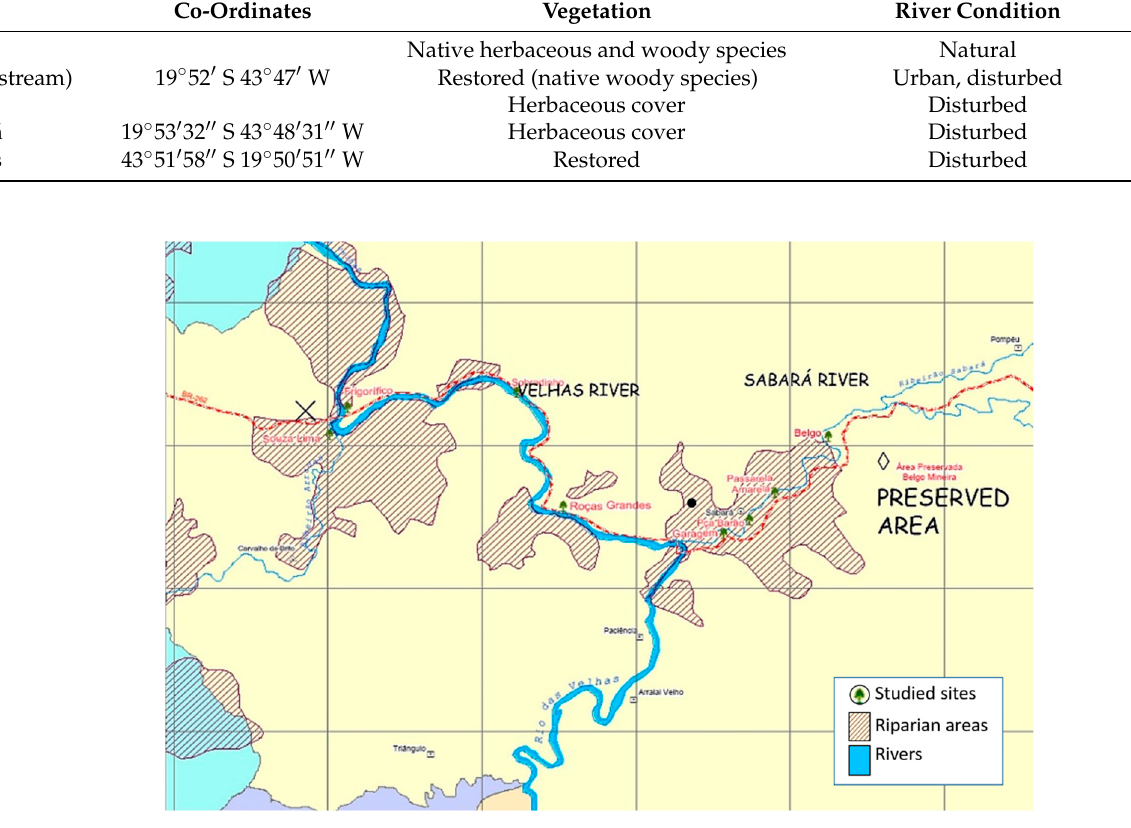
Figure 1. Studied riparian sites: ◊ = preserved site, • = Sabará river, and × = Velhas river. The climate of the region is tropical Aw with a dry winter (Köppen climate classifi- cation), with an annual mean temperature of 23 °C and annual mean precipitation of 1400 mm. Rainfall was unimodal-distributed, most coming between November and March (more than 400 mm monthly), followed by a prolonged dry season without or with few precipitations between May and August. The soil of the study site has sandy loam texture. The study was conducted in field sites previously used for cattle and agriculture practices. The field experiment consisted of a complete randomized block with three replications and each experimental plot was 150 m 2 , with 2 × 2.5 m spacing (Figure 2).